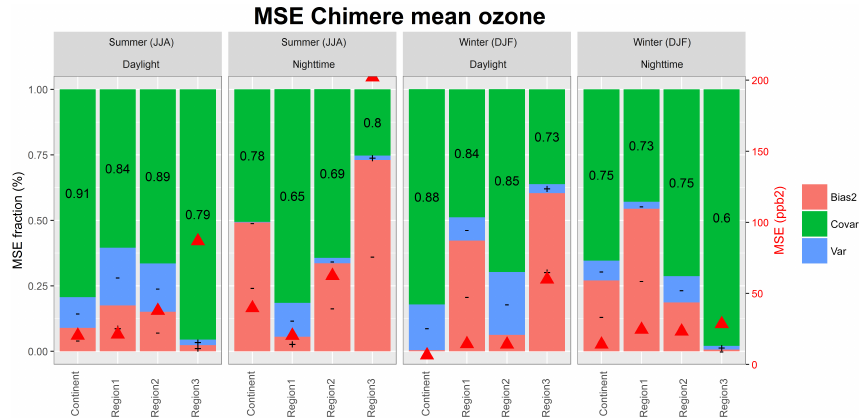
Figure 11. Chimere MSE breakdown for summer and winter for the base case (hourly time series of ozone) and sensitivity simulations over EU. The error coefficients F b , F v , and F c are reported on the left axis, the total MSE (ppb 2 ) on the right axis (red triangles). The + and − signs within the bias and variance portions of the errors indicate model over- and underprediction of mean concentration or variance, respectively. The values in the covariance portion indicate the correlation coefficient between modelled and observed time series. Results are provided separately for daytime and nighttime.